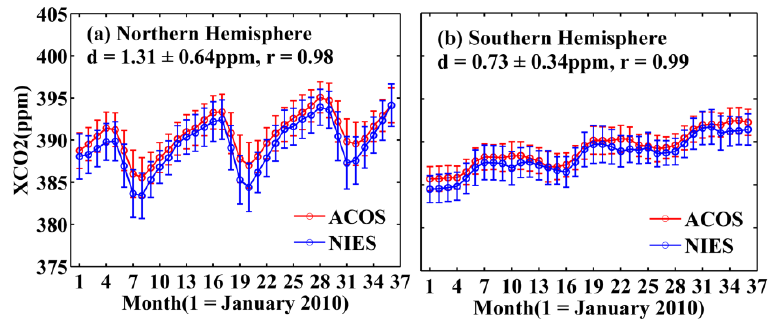
Figure 6. Time series of NIES and ACOS XCO 2 monthly mean in the Northern ( a ) and Southern ( b ) Hemispheres for three years. The mean difference d of ACOS to NIES and its corresponding standard deviation, and the correlation coefficient r between NIES and ACOS are evaluated based on the XCO 2 monthly means.